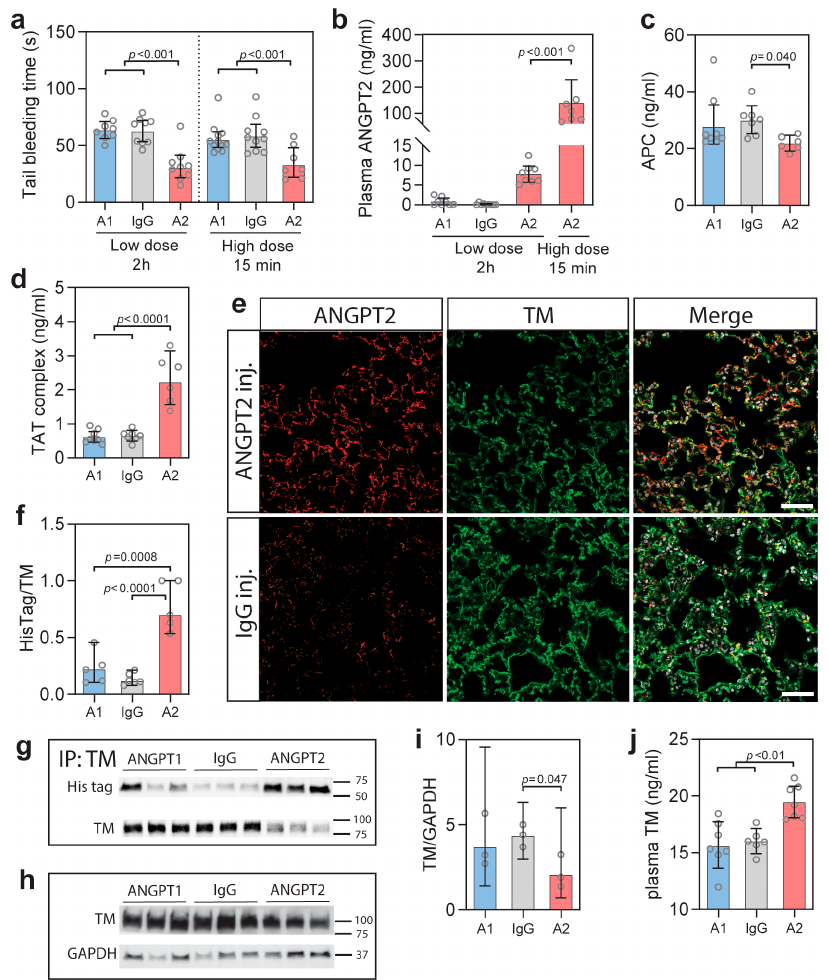
Figure 1. ( a ) Tail bleeding time after intraperitoneal (i.p.) injection of His-tagged ANGPT2 (A2), ANGPT1 (A1), and IgG with (8 nmol) and high dose (80 nmol) after 15 min or 2 h, as indicated; ( b ) Plasma concentrations of ANGPT2 after i.p. injections; ( c ) Plasma concentrations of activated protein C (APC) 15 after high dose injection of indicated proteins; ( d ) Plasma concentrations of thrombin/antithrombin (TAT) complexes 15 min after high dose injection of indicated proteins; ( e ) Immunohistochemistry for human/mouse ANGPT2 and TM on lung tissue after administration of high dose of ANGPT2 or IgG for 15 min; ( f,g ) Representative blot and quantification of His-tag labelled proteins after immunoprecipitation of TM in lung tissue 15 min after intraperitoneal (i.p.) injection of 80 nmol (high dose) of His-tagged ANGPT2 (A2), ANGPT1 (A1), and IgG. Full gels can be seen in the Supplementary Materials, Figure S1a; ( h,i ) Western blotting and quantification of TM in lung lysates from the same conditions as above. Full gels can be seen in the Supplementary Materials, Figure S1b; ( j ) Plasma sTM 15 min after injection of 80 nmol ANGPT2 (A2), ANGPT1 (A1), and IgG. Data presented as mean ± 95% CI. Statistical comparison from one-way ANOVA with Bonferroni post hoc test.